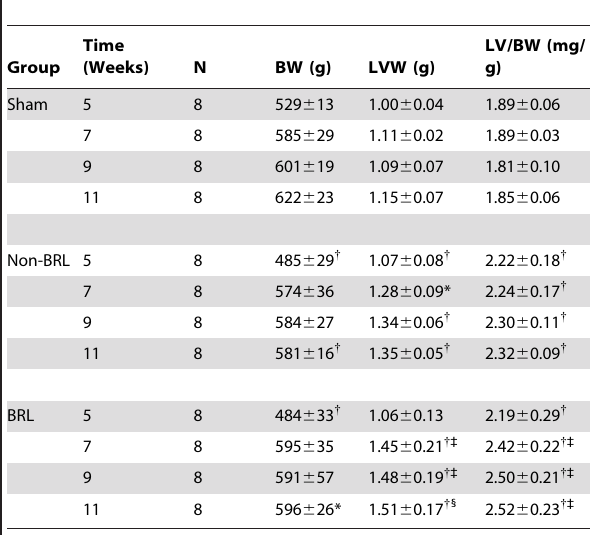
Table 2. The ratio of left ventricle weight to body weight following injection.